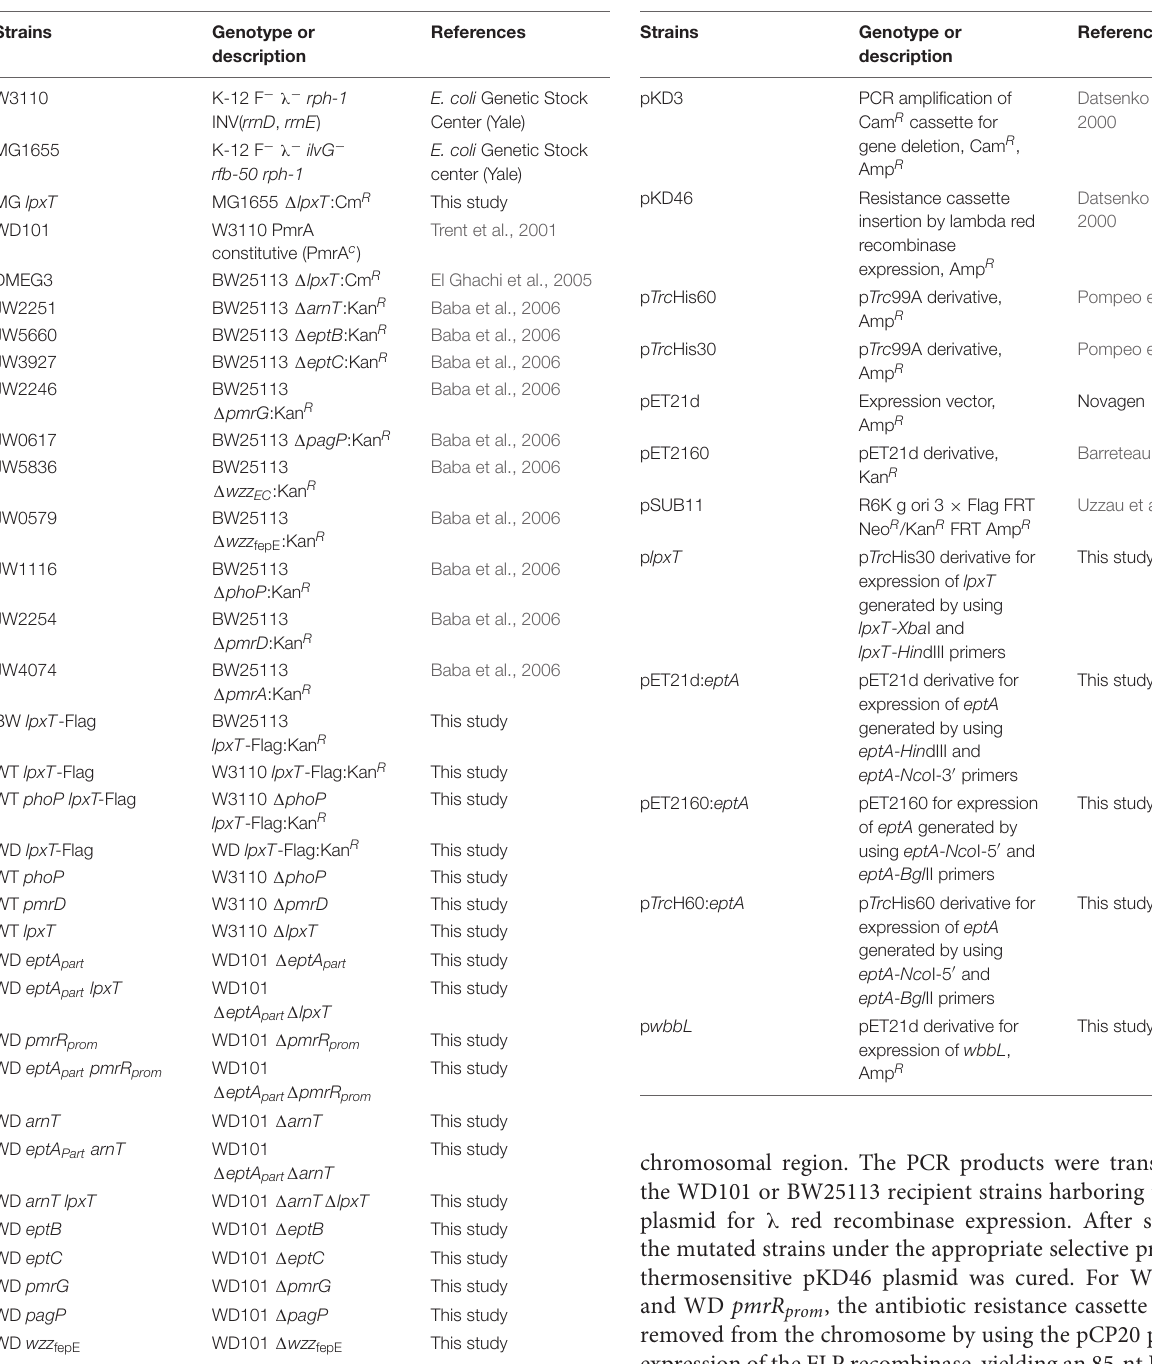
TABLE 1 | Bacterial strains and